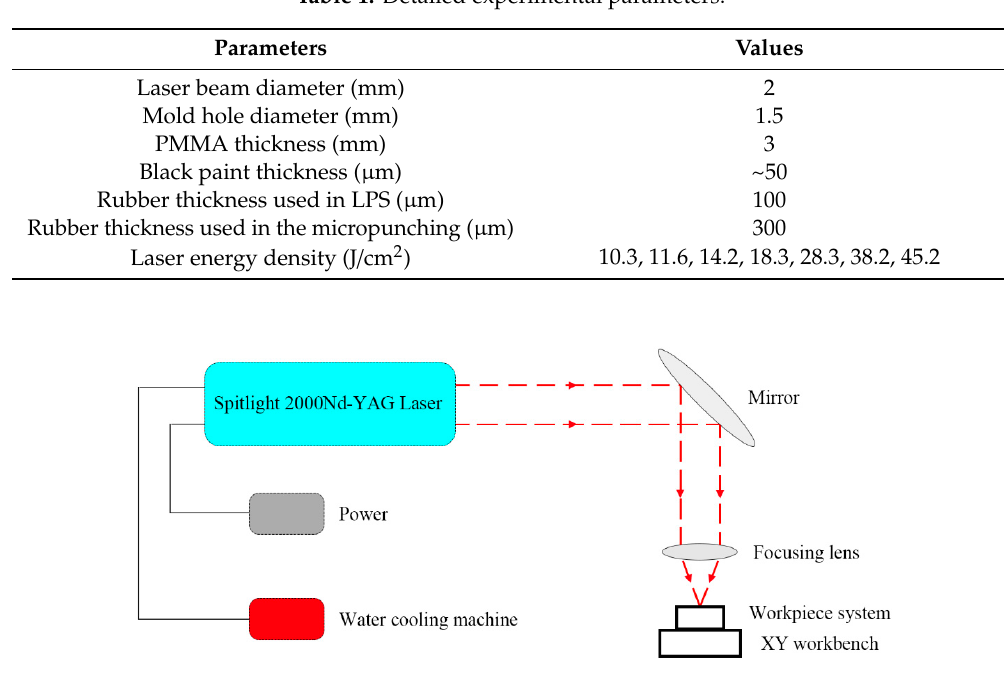
Figure 1. Schematic of the laser dynamic flexible micropunching process.